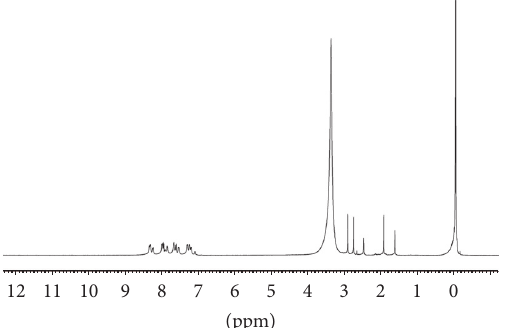
Figure 6: 1 H NMR spectrum of SPAEB copolymer.